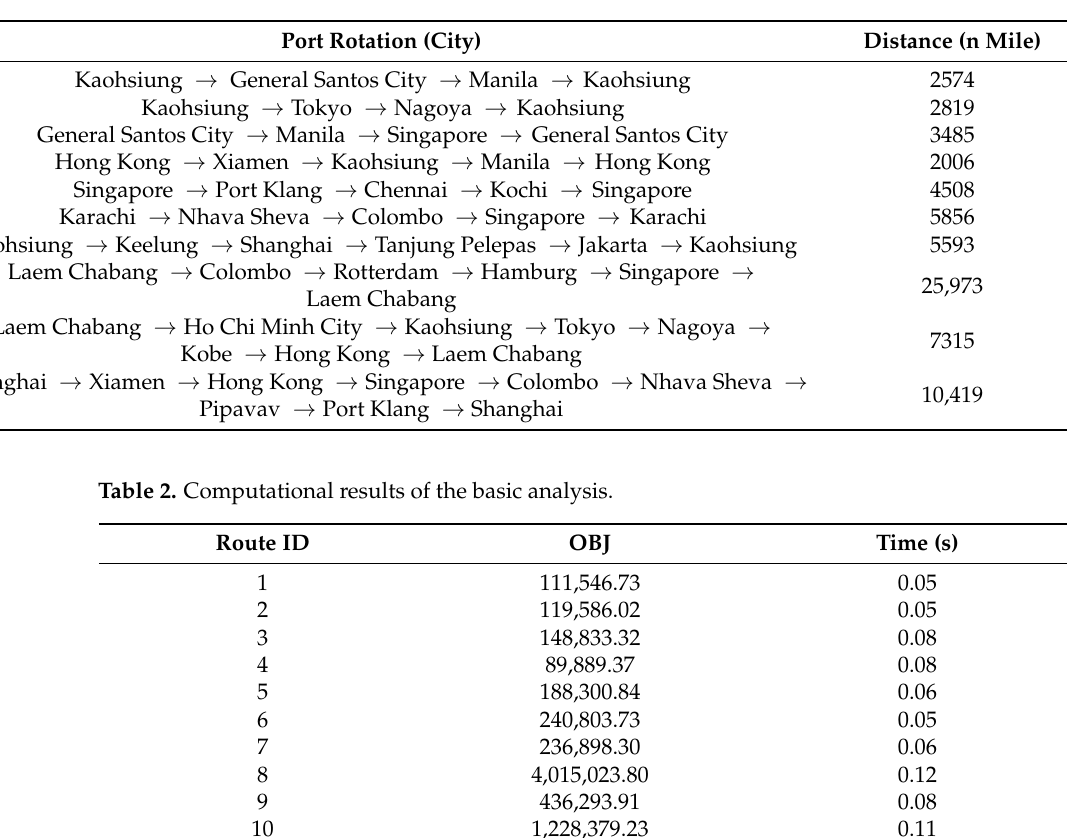
Table 1. Summary of 10 routes.